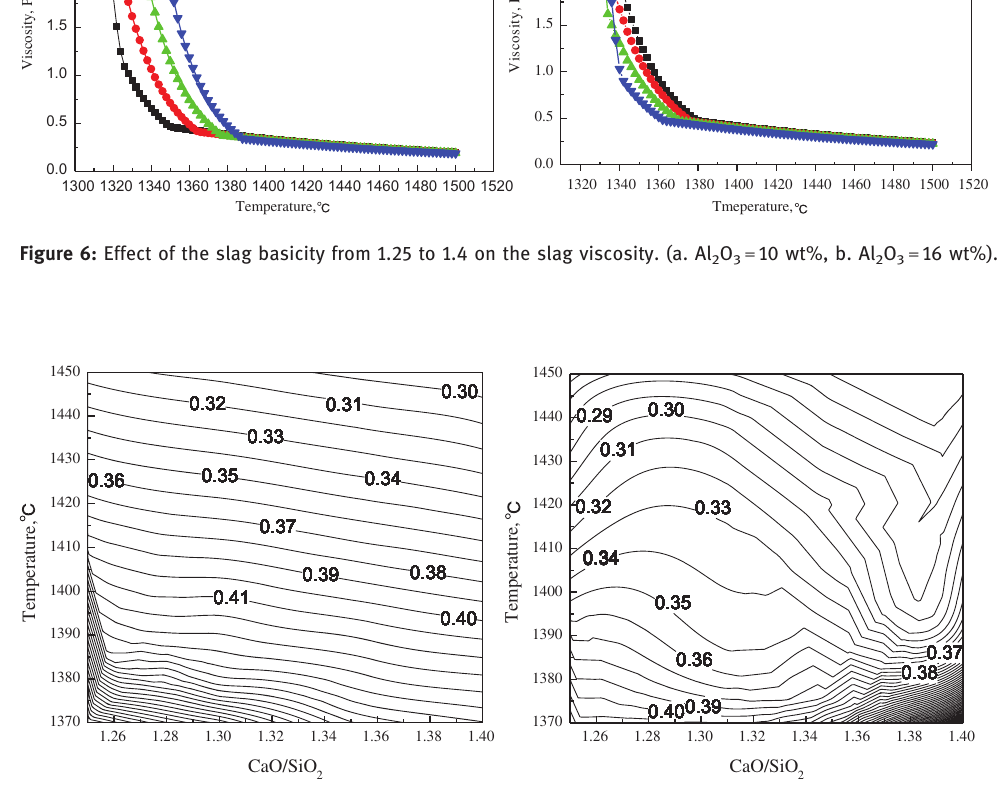
Figure 7: Influence of MgO/Al 2 O 3 ratio and temperature on viscosity for Al 2 O 3 = 10 wt% (a) and Al 2 O 3 = 16 wt% (b).